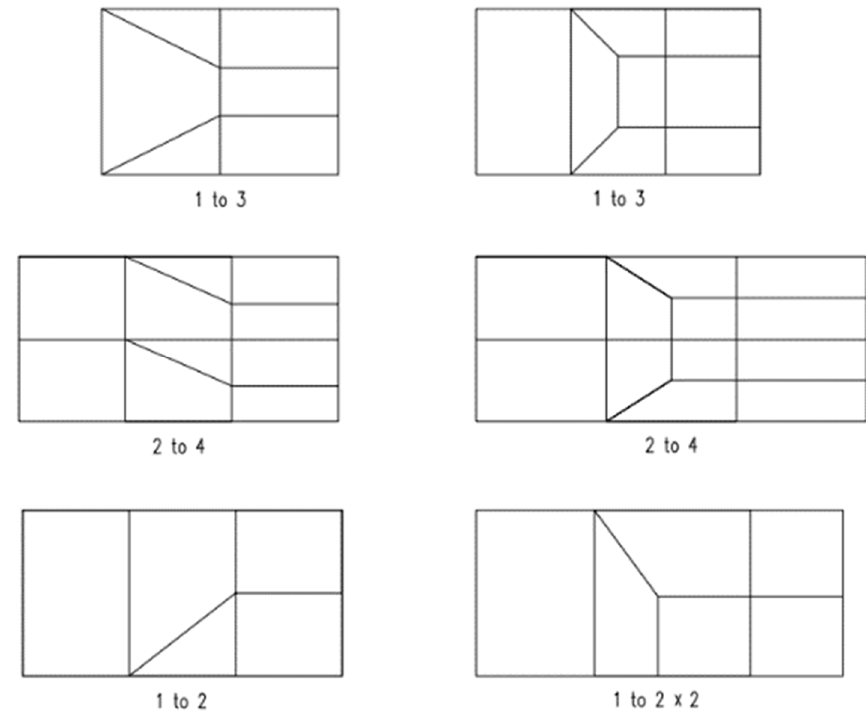
Figure 3. Finite-element mesh transition techniques.